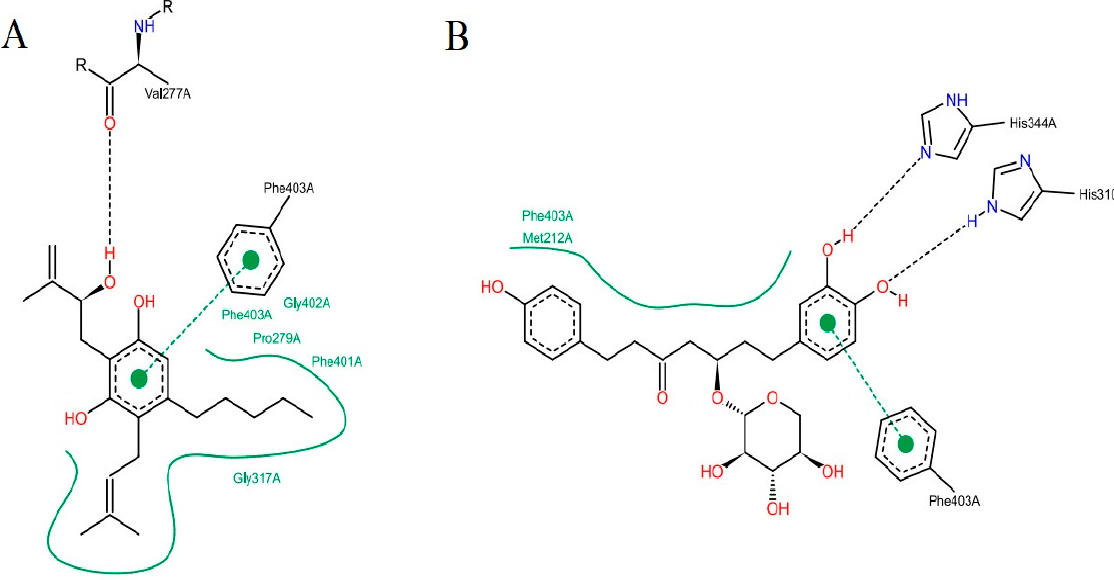
Figure 7. Interactions of compounds against the active site of Mycobacterium tuberculosis KasA, In ( A ) ZINC35465970 and ( B ) ZINC31170017.